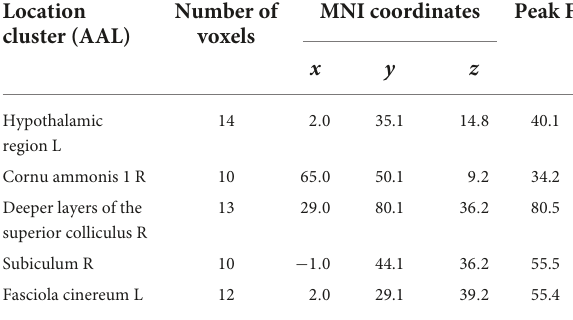
TABLE 1 Regions showing amplitude of low-frequency fluctuation (ALFF) differences among the sham, day 7 post cecal ligation and perforation (CLP), and day 14 post CLP